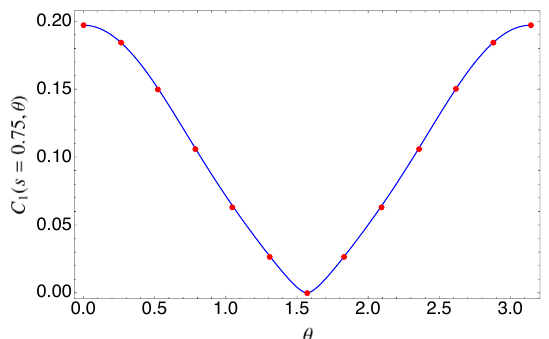
Figure 4 . The coefficient of the logarithmic term of the negativity between two wires ( A and B ) as a function of θ , with fixed s = 0 . 75 . The solid line corresponds to eq. (3.23) while the points have been obtained through a fit of the numerics with the form a log N + b